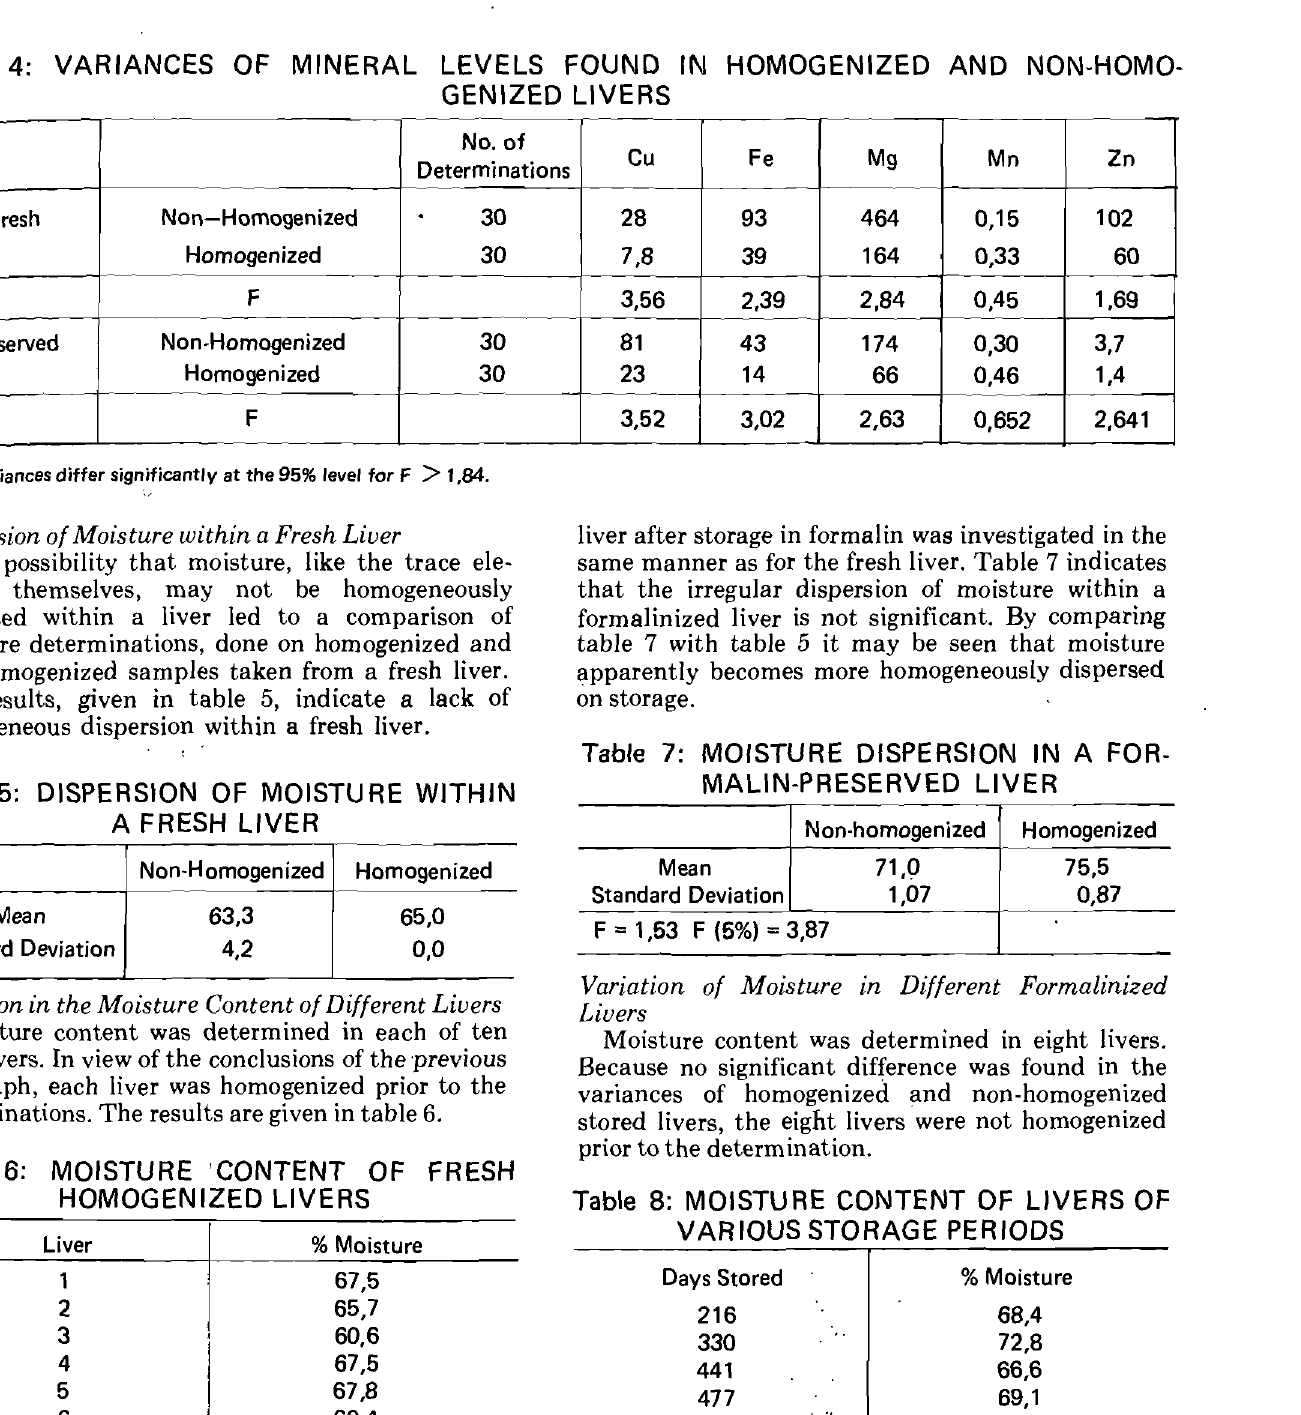
Table 4: VARIANCES OF MINERAL LEVELS FOUND IN HOMOGENIZED AND NON-HOMO GENIZED LIVERS